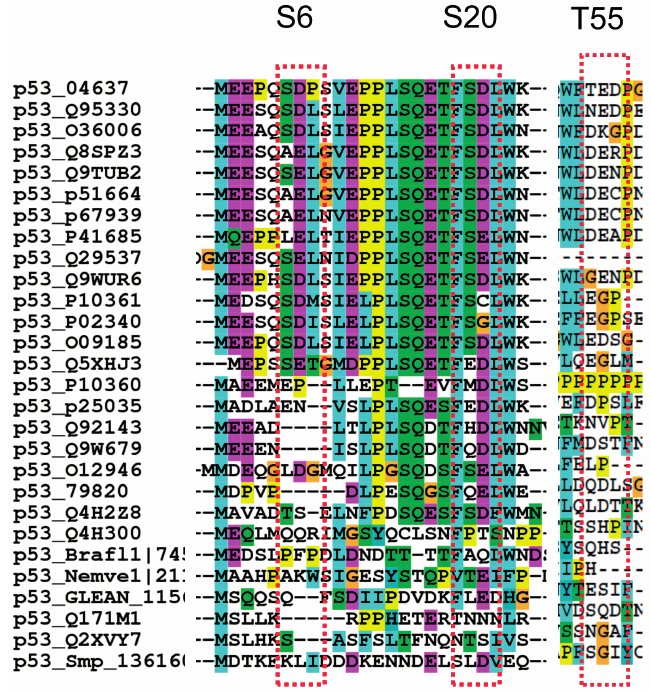
Figure 2. Sequence alignments near several phosphorylation sites indicate that acidic residues near phosphorylation sites are conserved in p53 proteins. The number after p53 indicates the protein access number in pubmed. See reference